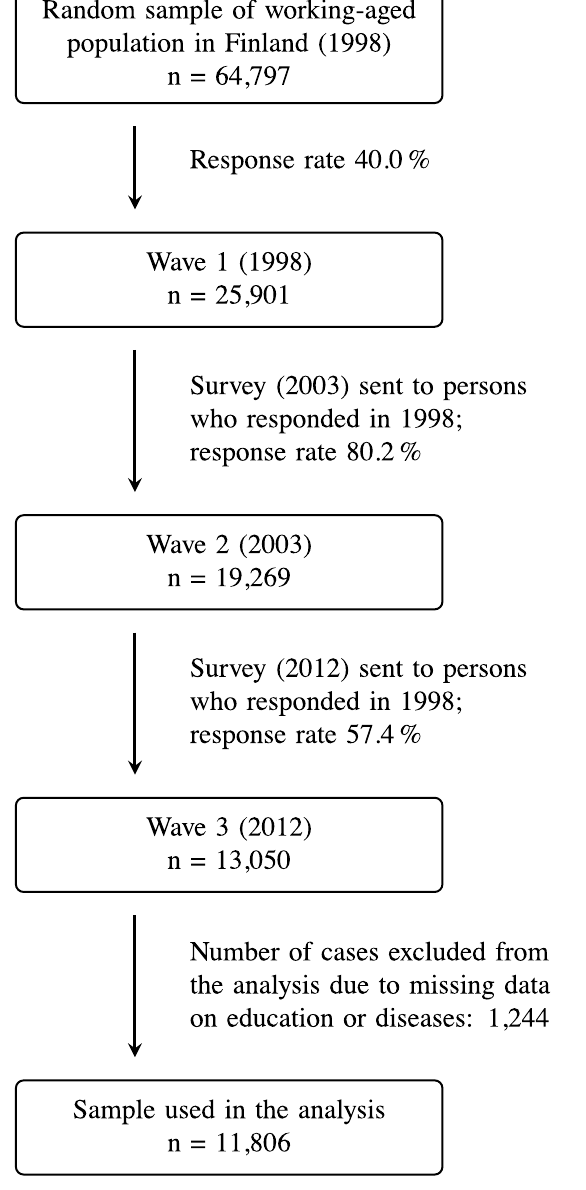
Fig 2. Outline of population data selection. Inclusion and exclusion criteria for the present study population from the Health and Social Support (HeSSup) prospective population-based follow-up